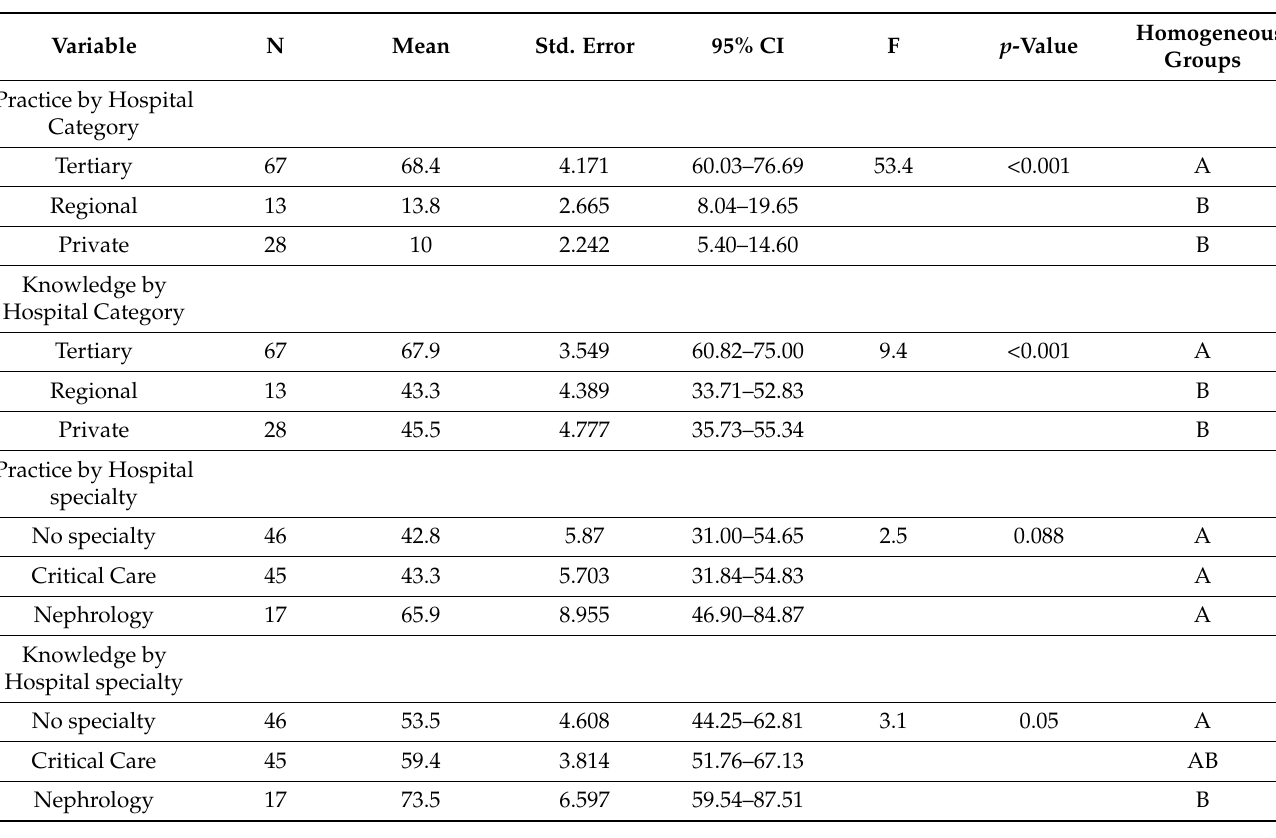
Table 4. Comparisons of practice and knowledge by hospital specialty post hoc